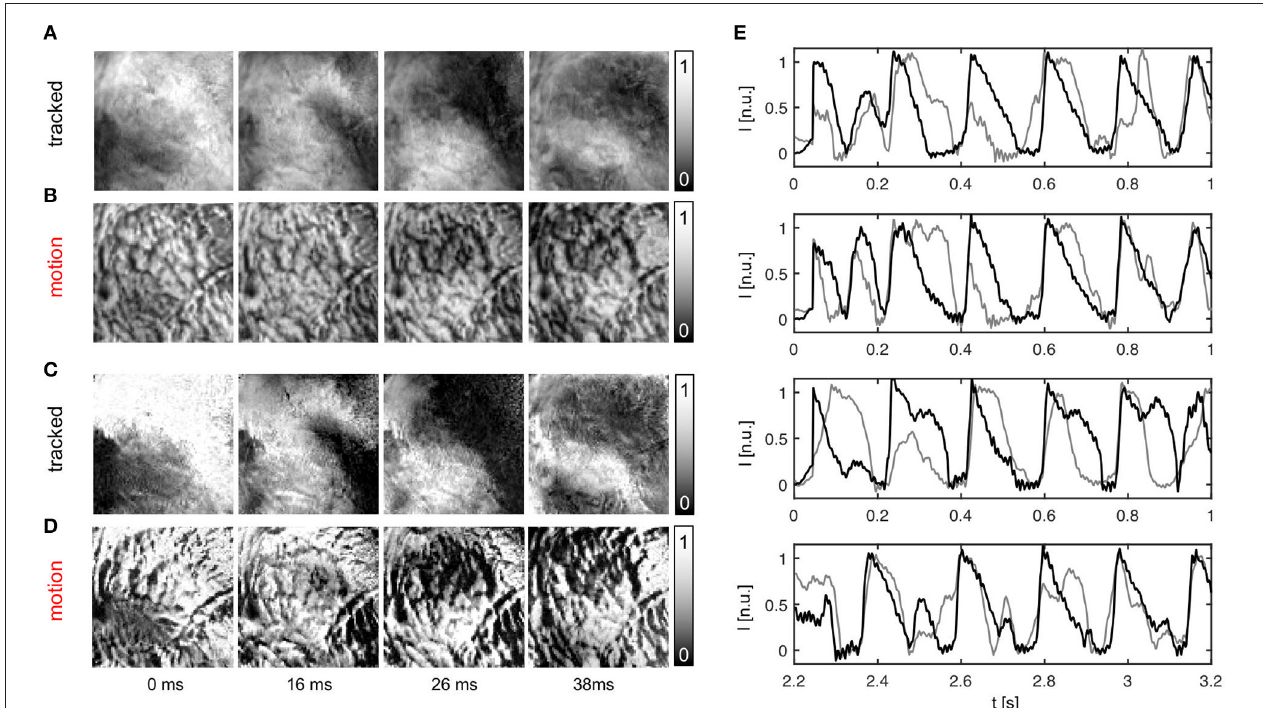
FIGURE 7 | Action potential vortex waves mapped on contracting left ventricular surface of rabbit heart during ventricular fibrillation. Electromechanical optical mapping was performed with voltage-sensitive staining (Di-4-ANEPPS, 128 × 128 pixels, 500 fps, approx. 1 × 1 cm field of view). (A,C) Maps with substantially inhibited motion artifacts after tracking and motion-stabilization showing action potential waves. (B,D) Action potential wave maps without tracking and motion stabilization. Maps exhibit strong motion artifacts. In (A,B) and (C,D) the same activity is shown with two different normalizations, see main text. (E) Exemplary time-series obtained from optical maps with motion before (gray) and after tracking and numerical motion-stabilization